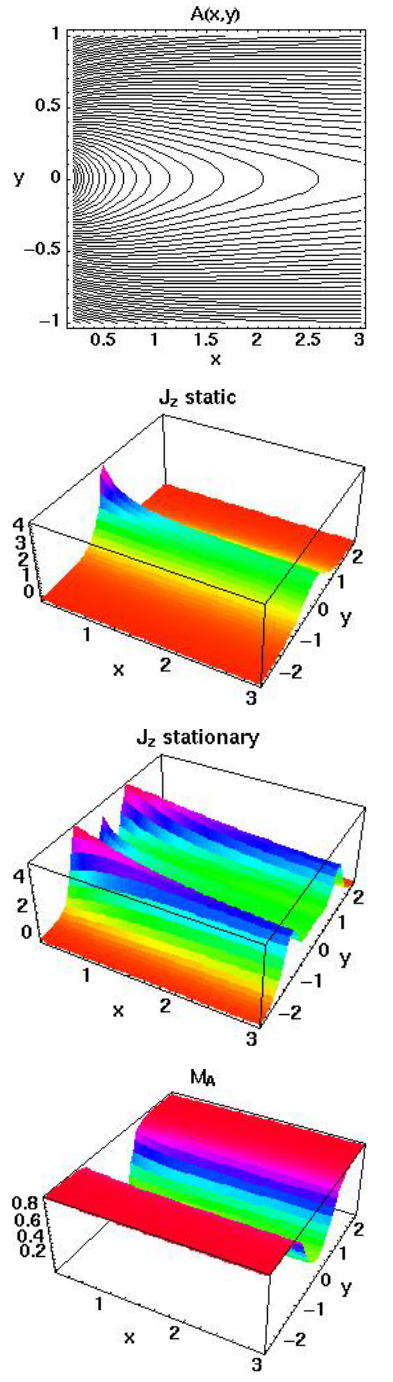
Fig. 6. Same transformation formula as Fig. 2, but for a nonlinear current in the form J z (A) ∝ exp ( − cA) . For the transformation we used M 1 = 0 . 0, M 2 = 0 . 95 and d = 2. For a better visualization we show the negative current − j z (x,y) in the second and third